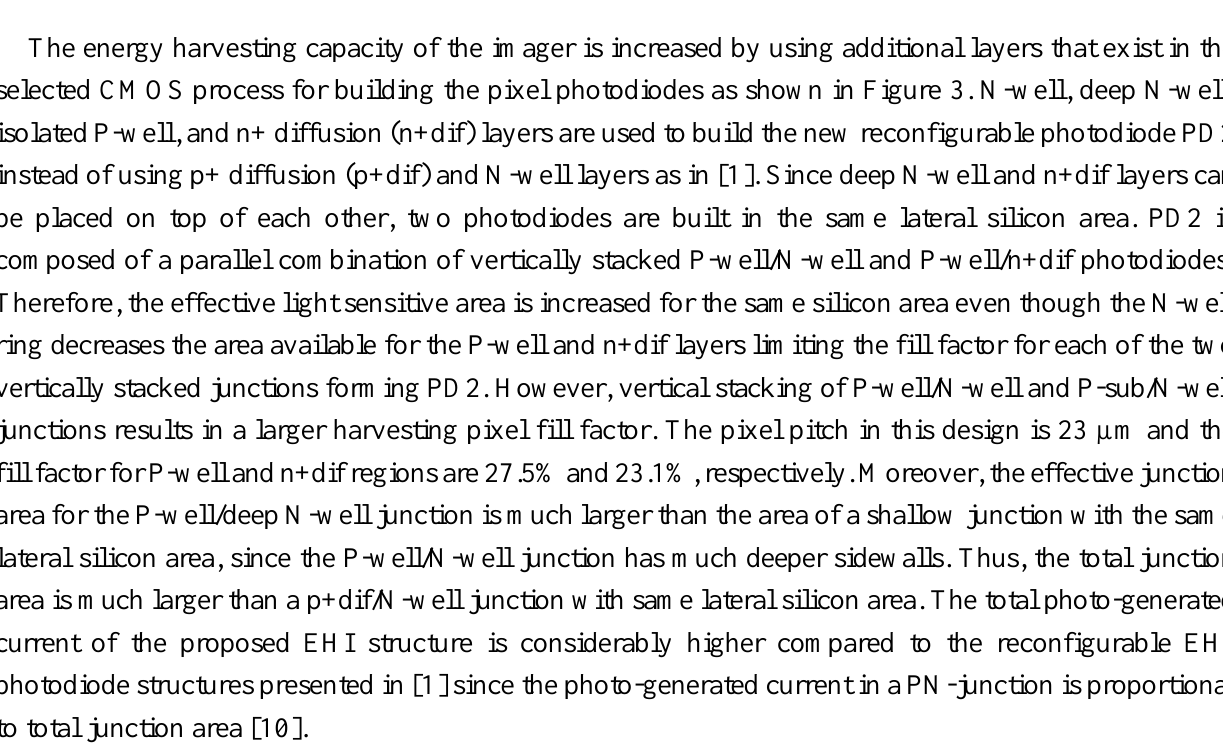
Figure 2. Dual-mode CMOS EHI APS pixel: ( a ) circuit schematic; ( b ) energy harvesting mode (EHM) configuration; ( c ) imaging mode (IM)